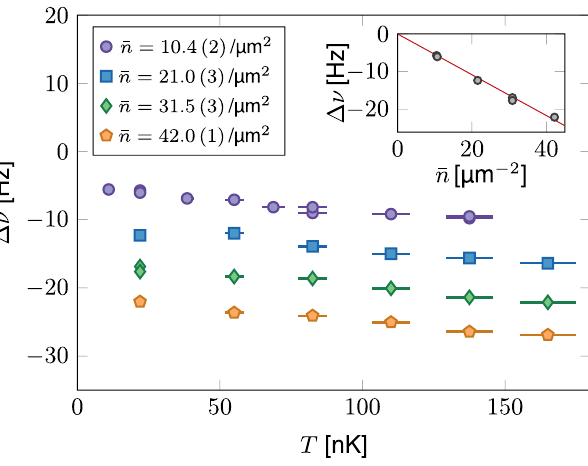
Fig. 2 Frequency shift of the resonance. Variations of the shift Δ ν with temperature for various 2D spatial densities. The horizontal error bars represent the statistical uncertainty on the temperature calibration, except for the points at very low temperature (10 – 22 nK). These ultra-cold points are deeply in the Thomas – Fermi regime, where thermometry based on the known equation of state of the gas is not sensitive enough. The temperature is thus inferred from an extrapolation with an evaporation barrier height of the higher temperature points. The error on the frequency measurement is below 1 Hz and is not shown in this graph. Inset: Variations of the shift Δ ν with density at low temperature T ~ 22 nK, i.e., a strongly degenerate gas. The straight line is the mean- fi eld prediction corresponding to Δ a = − 5.7 a 0